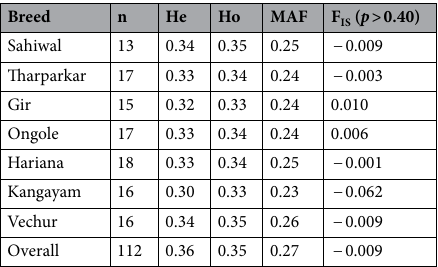
Table 1. Number of animals, mean of expected and observed heterozygosity (He, Ho), minor allele frequency (MAF) and coefficient of inbreeding (F IS